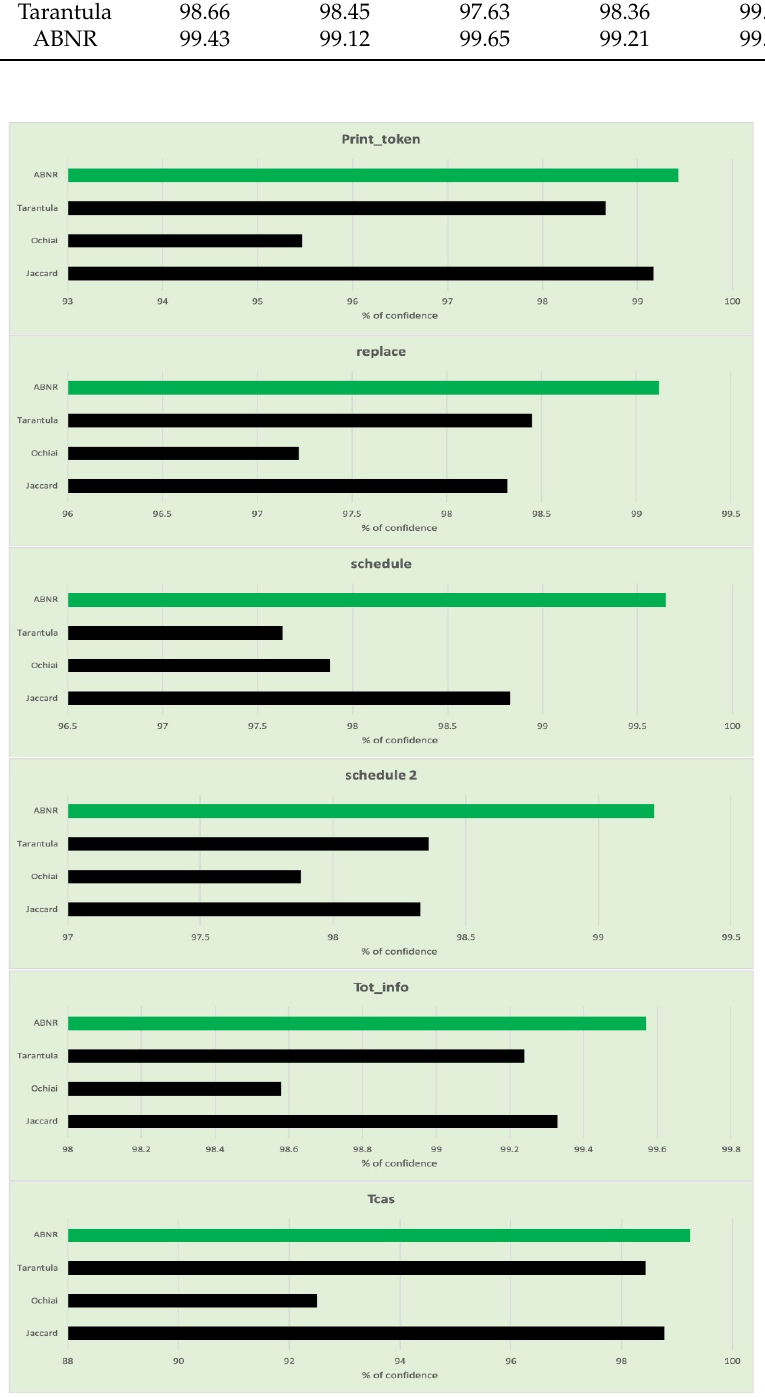
Figure 7. Graphs representing the confidence level of fault localized for each category in Siemen’s validation set .